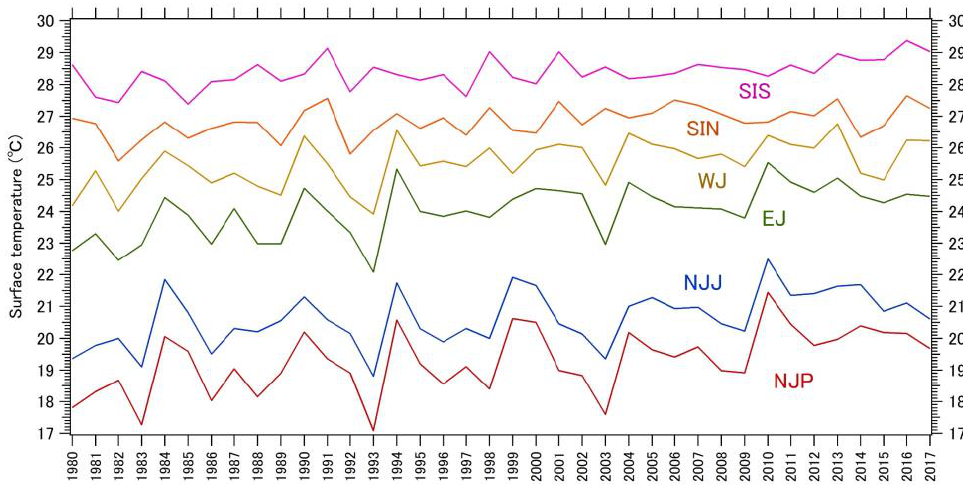
Figure 2. Temporal variation in surface temperature for summer (June–August) in six regions of Japan. The blue, brown, green, gold, orange, and pink lines show the surface temperature in NJJ, NJP, EJ, WJ, SIN, and SIS, respectively.